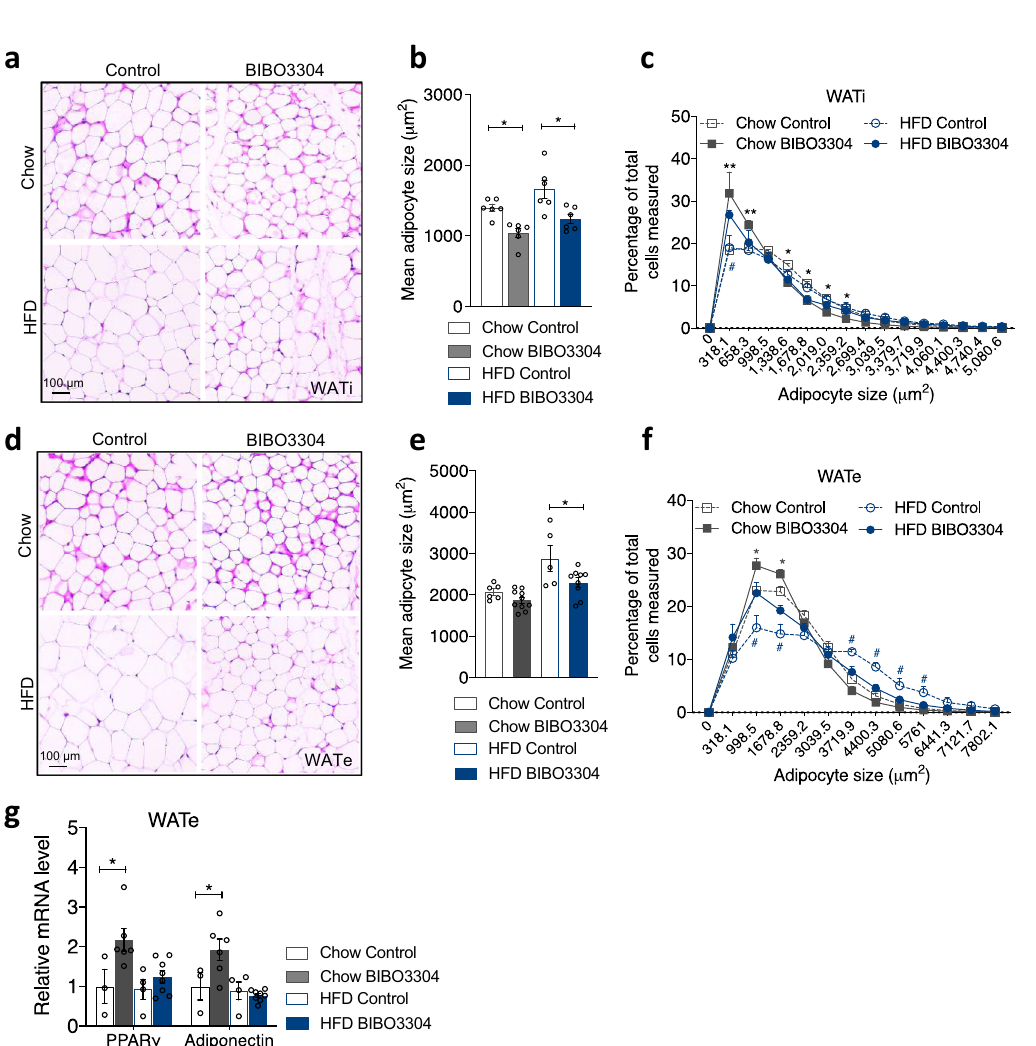
Fig. 6 Effects of peripheral Y1R antagonism on adipocyte size and distribution. a d H&E staining of WATi and WATe of vehicle- and BIBO3304-treated wild-type mice on either a chow or a HFD. Images are representative of three independent experiments. b , e Average adipocyte size of WATi and WATe in BIBO3304-treated mice relative to that in vehicle-treated mice. Data are mean ± s.e.m, n = 4 per group (chow, control: open grey; BIBO3304: grey. HFD control: open blue; BIBO3304: blue). * p < 0.05, one-way ANOVA with Tukey ’ s multiple comparisons test. c , f The frequency distribution of adipocyte size in WATi and WATe from vehicle- and BIBO3304-treated mice on a chow or a HFD. Data are mean ± s.e.m, n = 6 per group (chow, grey; HFD, blue. control: open square; BIBO3304: fi lled square). * p < 0.05, ** p < 0.01 BIBO3304 vs control in chow; # p < 0.05 BIBO3304 vs control in HFD, two-way repeated measures ANOVA. g The mRNA levels of adipogenic markers in epididymal WAT (WATe) of chow- or HFD-fed wild-type mice treated with vehicle or BIBO3304 jellies. Data are mean ± s.e.m, chow: control n = 3 (open grey), BIBO3304 n = 6 (grey); HFD: control n = 4 (open blue), BIBO3304 n = 8 (blue). * p < 0.05, two-way ANOVA with Sidak ’ s multiple comparisons test. Source data are provided as a Source Data fi